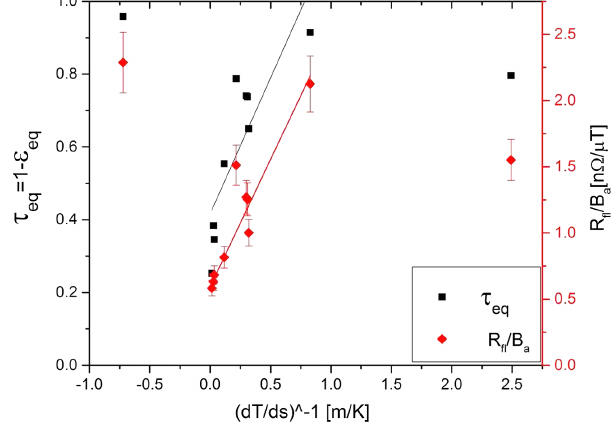
ð¼ 1 − ϵ Þ and R eq eq fl